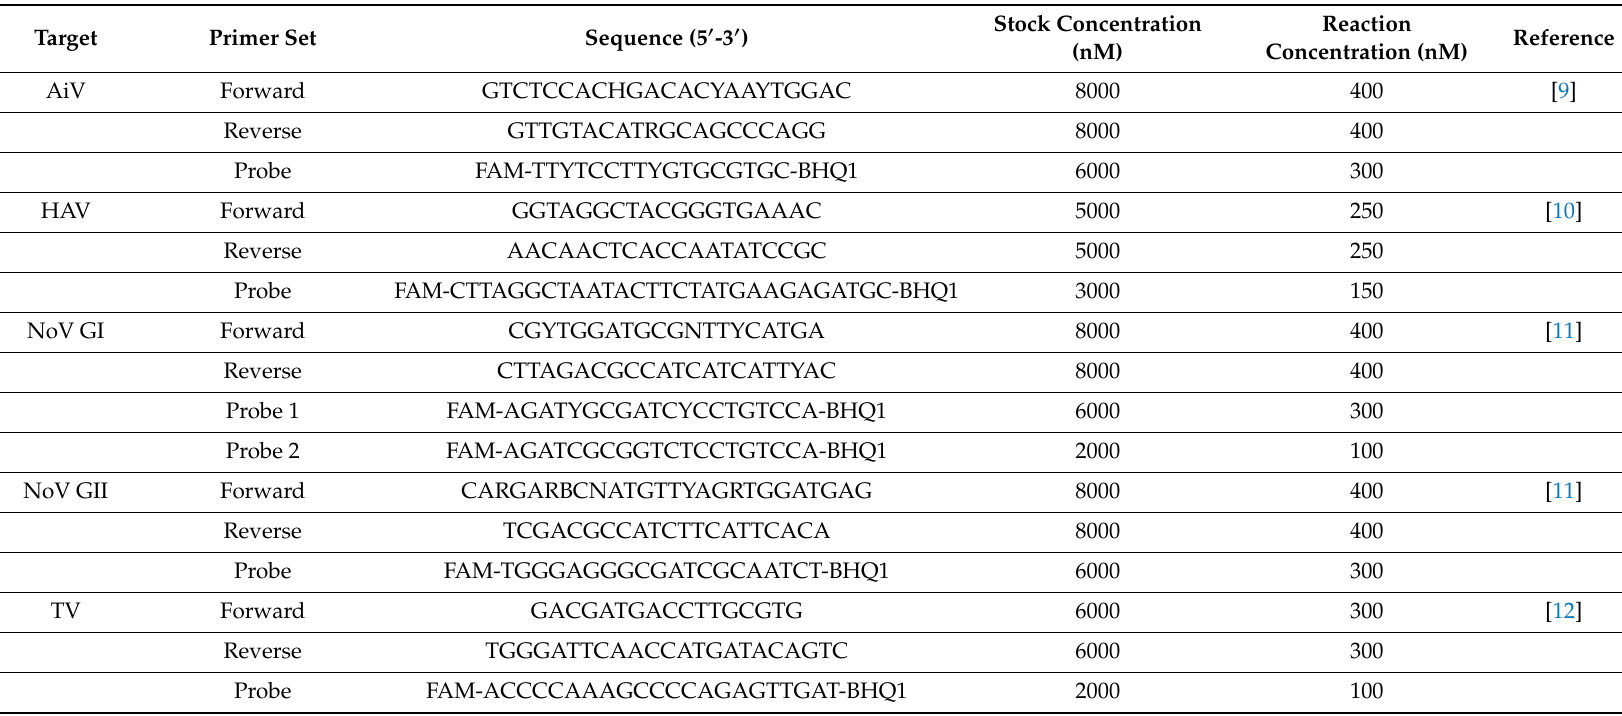
Table 1. Aichi virus (AiV), hepatitis A virus (HAV), noroviruses GI and GII (NoV GI and GII) custom primers and probes sequences and concentrations used for the detection of viral